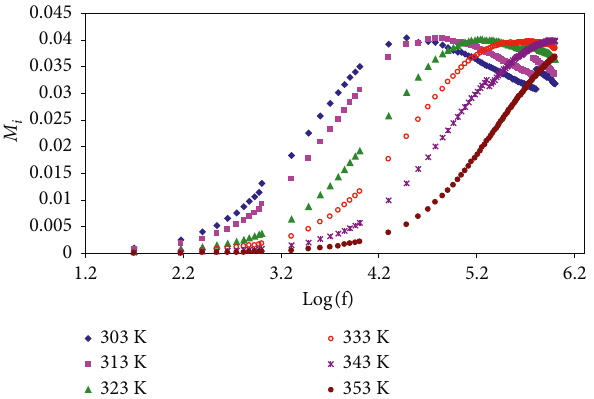
Figure 13: Imaginary part ( M i ) of electric modulus versus fre- quency at selected temperatures for the PBS3 blend sample.